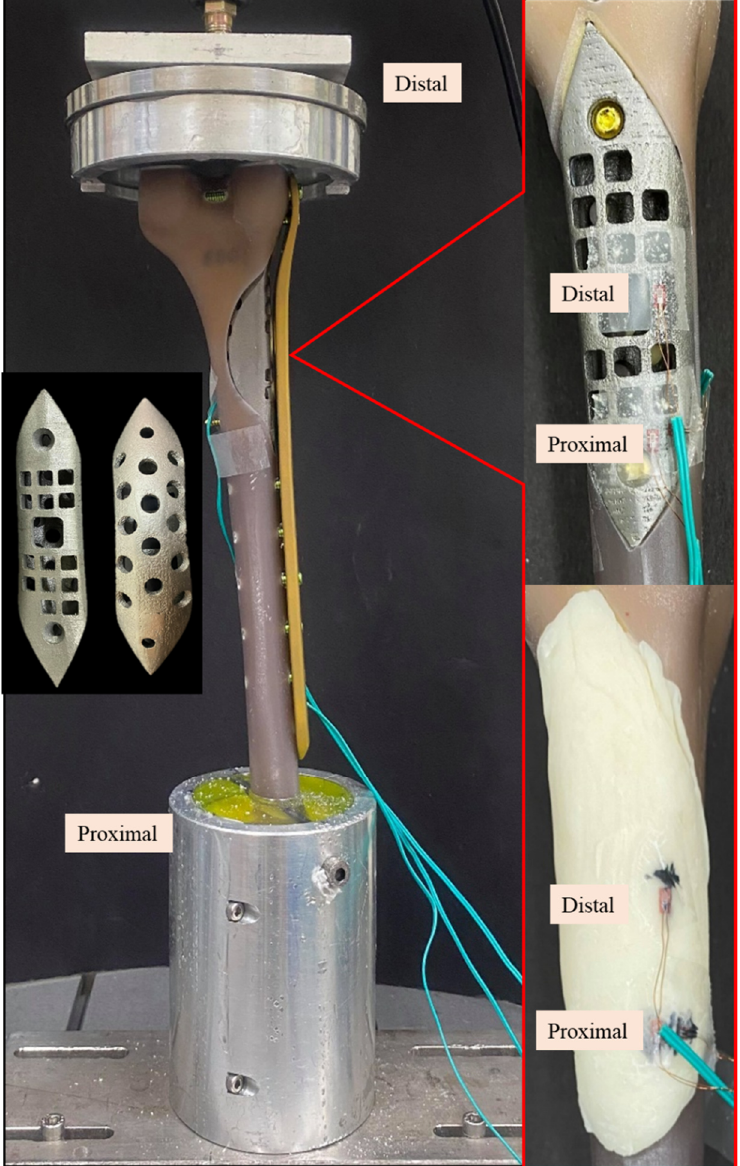
Figure 6. Photographic images of the Sawbone femur with a distal large defect repaired with a bone scaffold implant (upper right) and bone cement (lower right) under cyclic load test. Left middle image shows the top and back views of the bone scaffold implant manufactured by 3D printing.